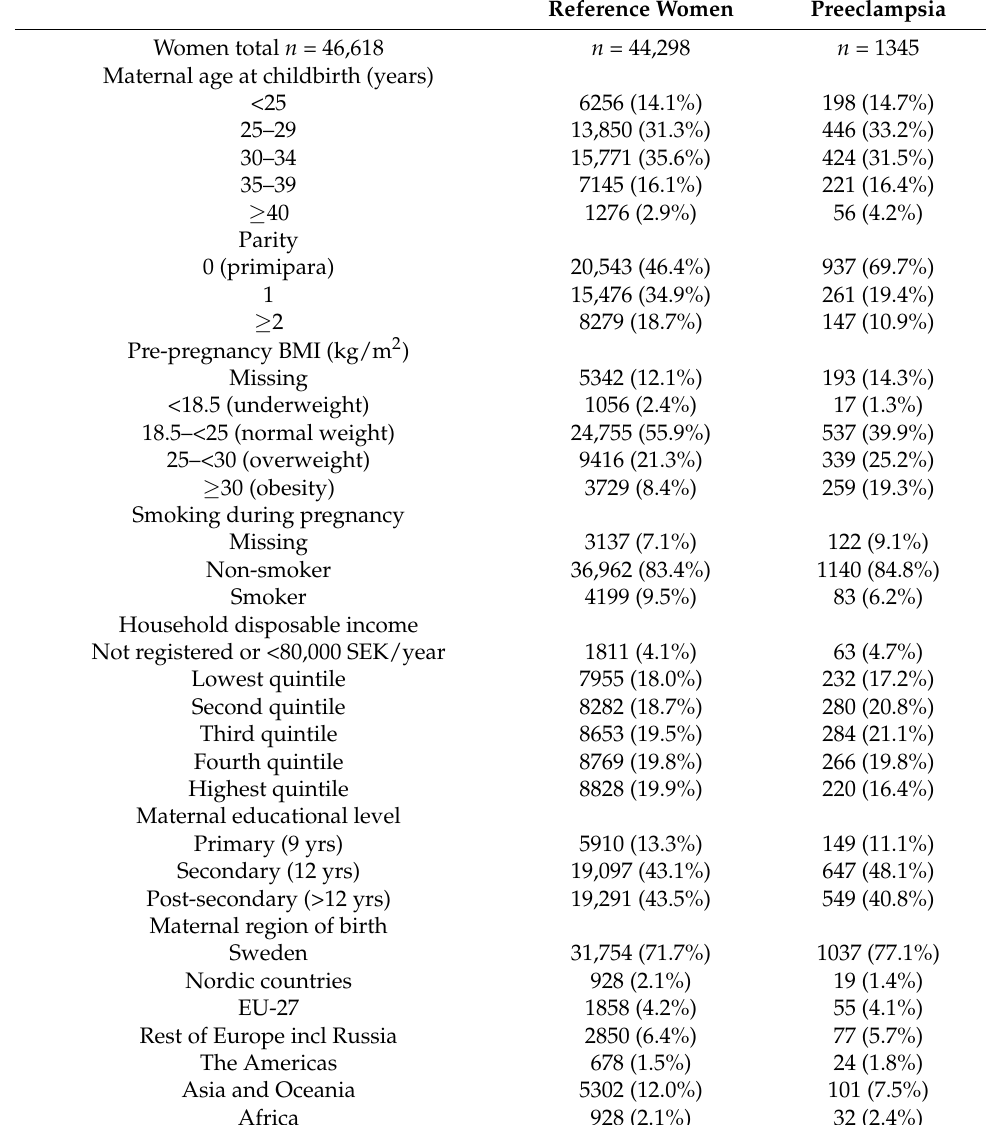
Table 1. Characteristics of women included in study population, numbers in n and